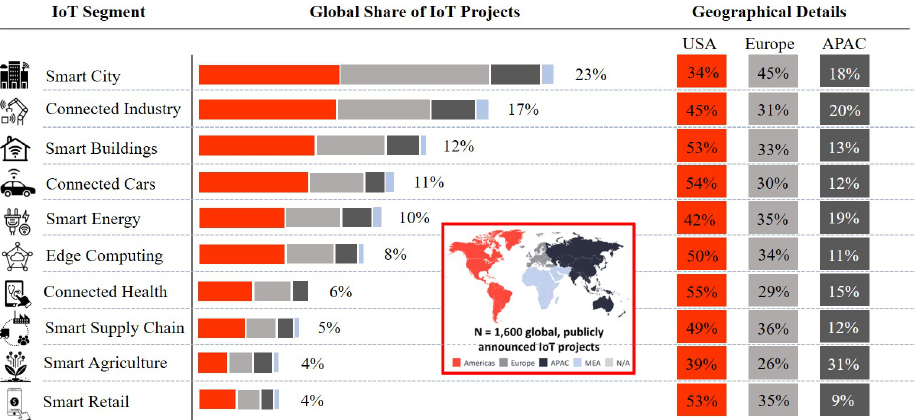
Figure 2. Statistics of Internet-of-Things (IoT) segments according to 2018 project and market survey with increasing trends in smart energy, edge computing, and smart supply chain. (Data Source: IoT-Analytics, Jan 2018. Based on 1600 enterprise projects announced world wide and not including consumer wearable IoT